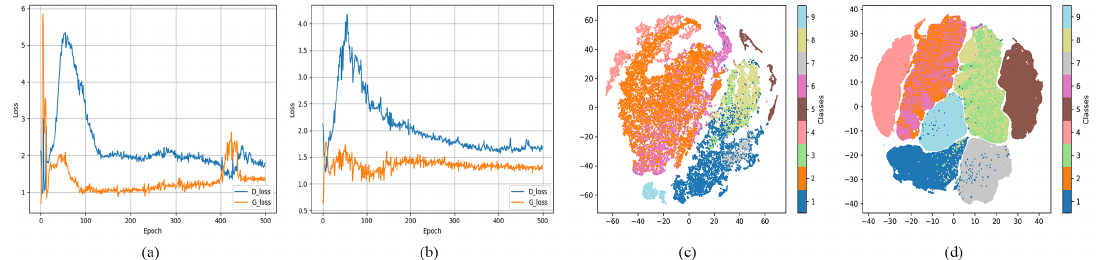
Figure 4. The training losses and sample 2D projection for SaGAAN with/without domain adaptation and self-attention: ( a ) the training loss values for SaGAAN without domain adaptation and self-attention; ( b ) the training loss values for SaGAAN with domain adaptation and self-attention; ( c ) the 2D projection of all available original hyperspectral samples; and ( d ) the 2D projection of generated hyperspectral samples using